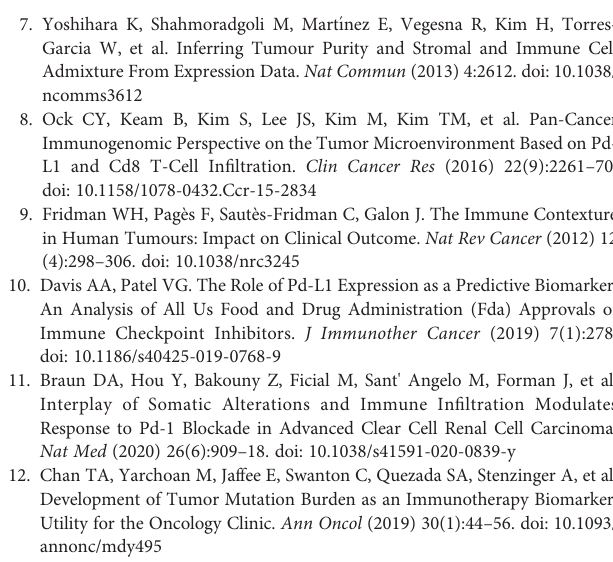
Supplementary Figure 1 | (A) Kaplan – Meier curves of OS for stages of ccRCC in ICGC cohort. (B) Kaplan – Meier curves of OS for phenotypes of ccRCC in ICGC cohort. (C) Time-dependent area under the ROC curve of stages and phenotypes for theOSinICGCcohort. (D) Kaplan – MeiercurvesofOSforstagesofKIRP. (E) Kaplan – Meier curves of RFS for stages of KIRP. (F) Kaplan – Meier curves of OS for stages of KICH. (G) Kaplan – Meier curves of RFS for stages of KICH. Supplementary Figure 2 | (A) Waterfall plot with recurrent and differential mutations among phenotypes of ccRCC (right) and forest plot of the univariate Cox regression analysis of mutations for OS (left) in ICGC cohort. (B) Forest plot of the univariate Cox regression analysis of mutations and SCNAs for OS and RFS in TCGA cohort. Supplementary Figure 3 | (A) Kaplan – Meier curves for OS of ccRCC with high and low levels of immunogenicity indicators. (B) Kaplan – Meier curves for RFS of ccRCC with high and low levels of immunogenicity indicators Supplementary Figure 4 | (A) Correlation of immunogenomic indicators with indicators related to extrinsic immune escape. (B) Correlation of ssGSEA scores of the pathways related to ccRCC progression. (C) Correlation of ssGSEA scores of the pathways related to ccRCC progression with indicators related to immune escape. Supplementary Figure 5 | (A) Boxplot showing the expression differences of HIF1A and HIF2A between Del(14q) and wild-type groups in TCGA cohort. (B) The differences in biological processes between Del(14q) and wild-type groups in TCGA cohort. NES: Normalized enrichment score. OXPHOS, Oxidative phosphorylation; EMT, Epithelial-Mesenchymal Transition; NES, Normalized Enrichment